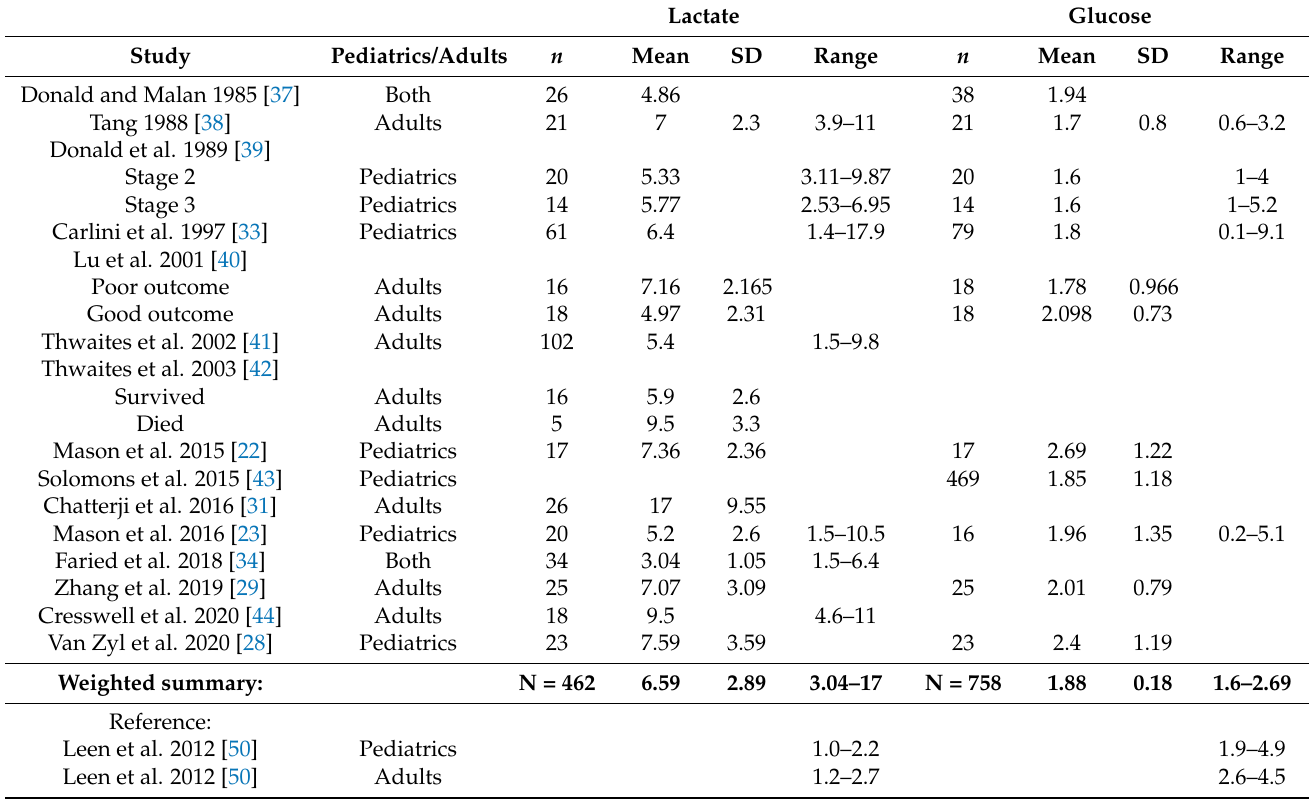
Table 3. CSF lactate and CSF glucose concentrations reported in TBM, as described by 15 studies over the past 25 years, including their weighted summaries and comparison to reference values. Concentrations are in mmol/L. SD = standard